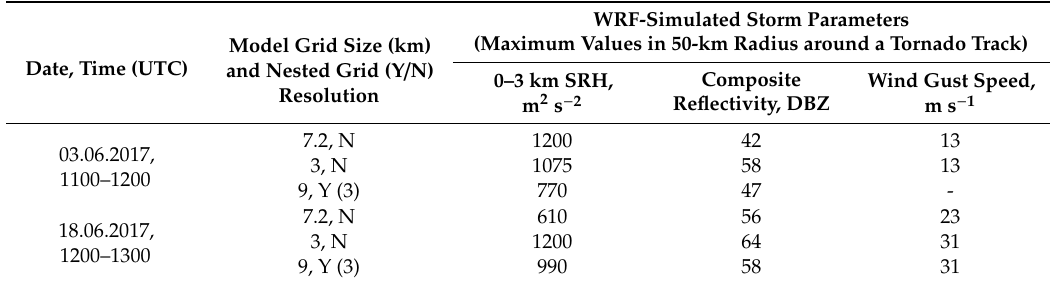
Table 3. WRF-simulated characteristics of tornadic storms 3 June 2017 and 18 June 2017.